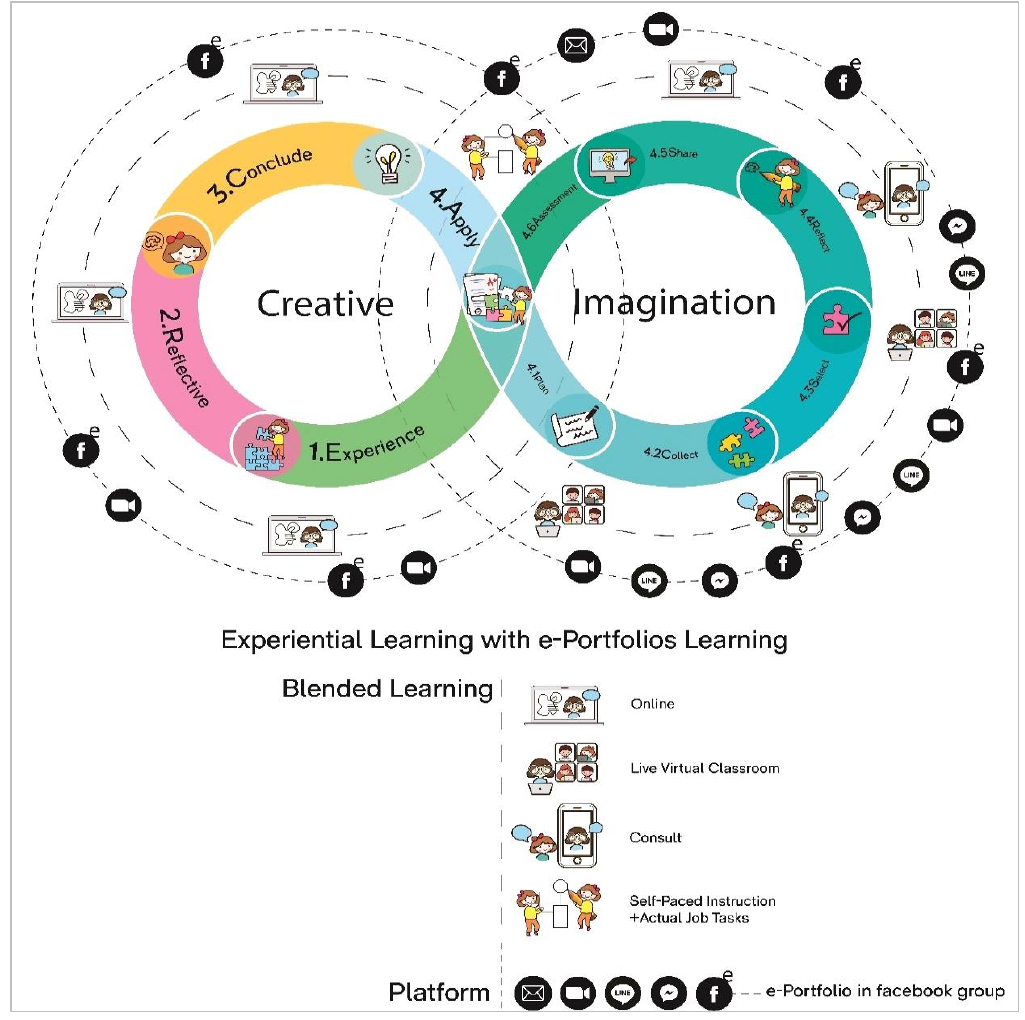
Figure 2. Blended Experiential Learning with e-Portfolios